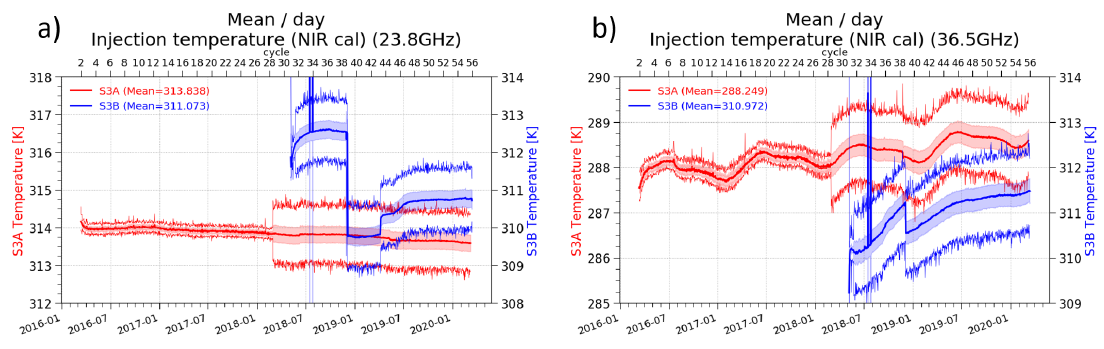
Figure 9. Daily noise injection temperatures for S3A (red) and S3B (blue). Bold lines show the average, shades the standard deviation and lighter lines are minimum/maximum values. ( a ) 23.8 GHz channel ( b ) 36.5 GHz